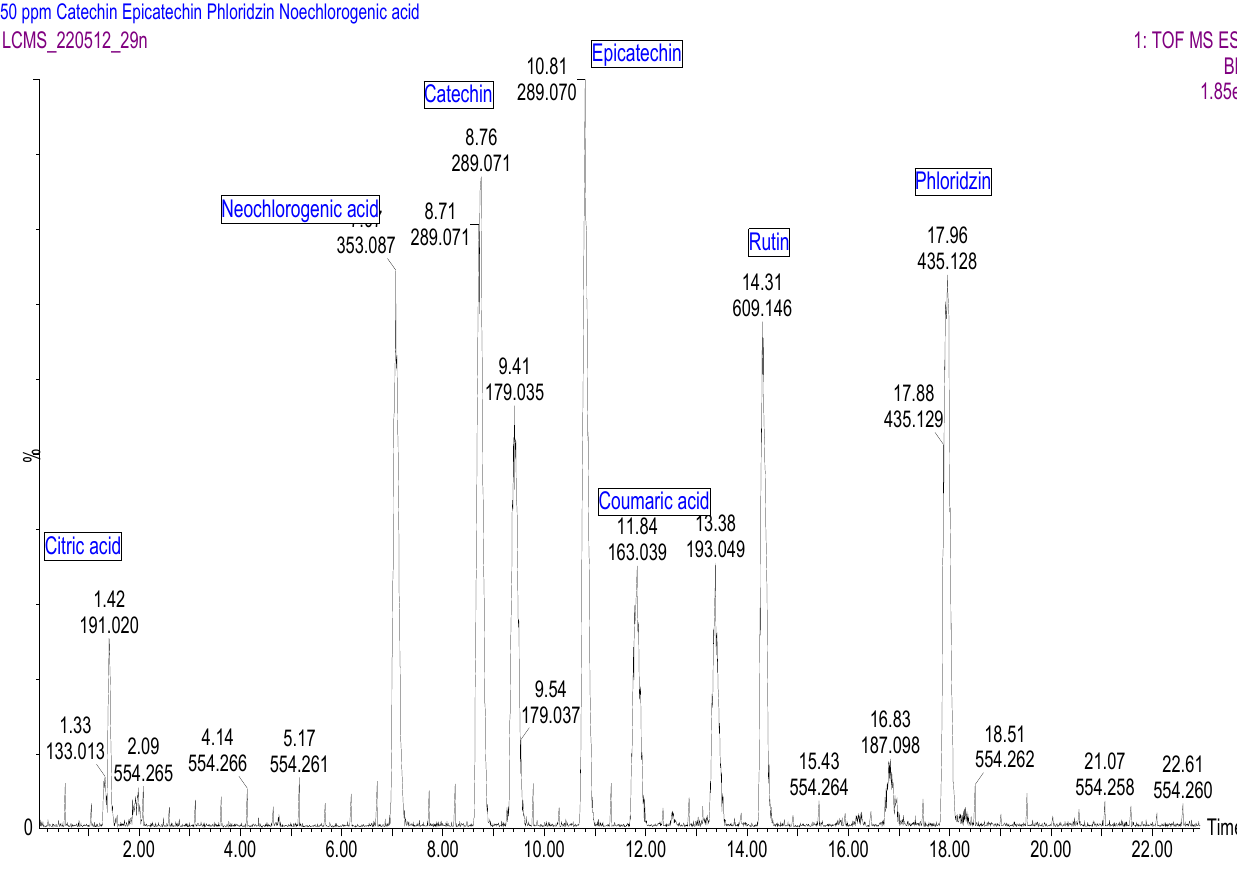
Figure 2. UHPLC-ESI-MS base peak chromatogram for the chloroform extract of E. africanus ’s neg- ative and positive ion modes.